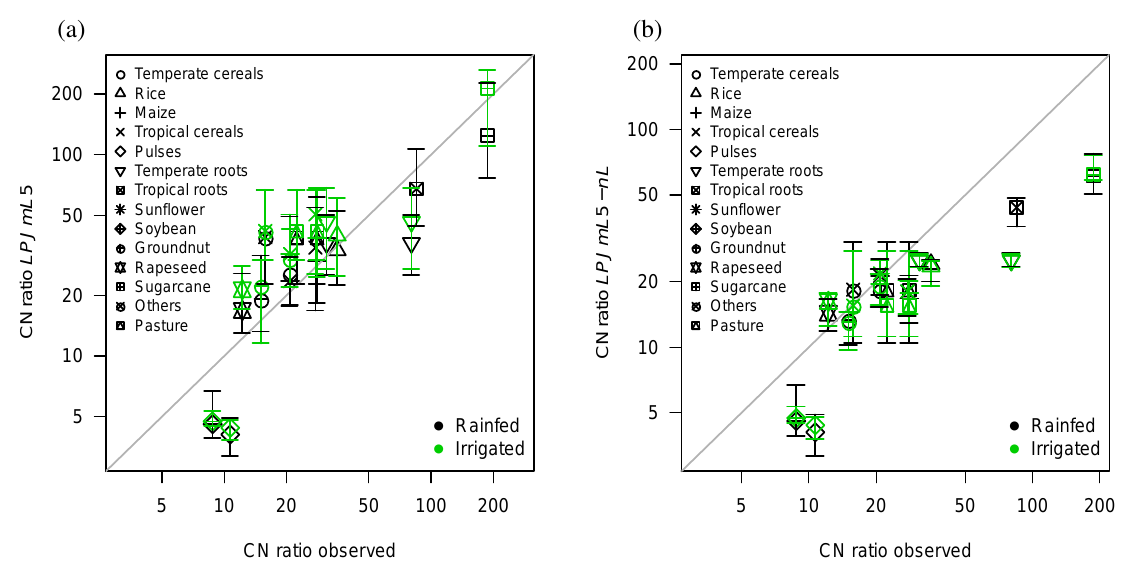
Figure 7. Observed C:N ratios of harvested crops versus simulated mean ratios for the crop PFTs (a) with N limitation ( LPJmL5 ) and (b) without N limitation ( LPJmL5-nL ). The vertical error bars denote the 95%